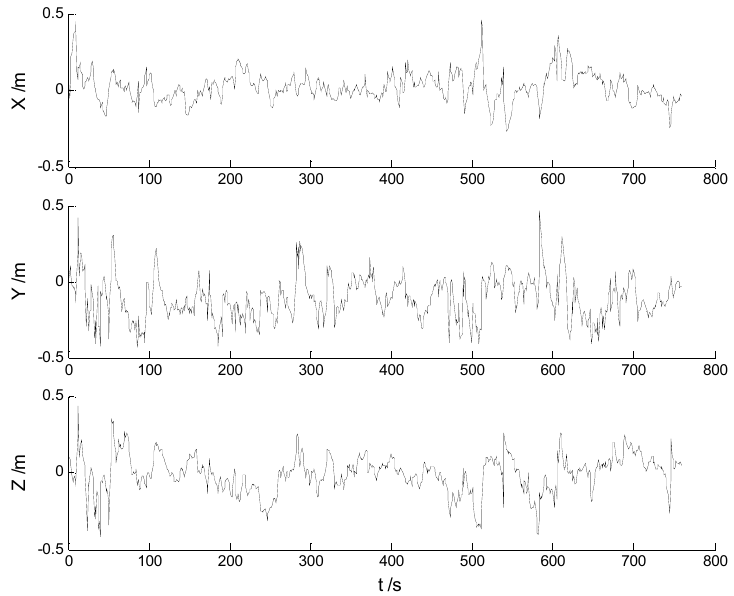
Figure 11. Position errors of the NMF-CKF algorithm.